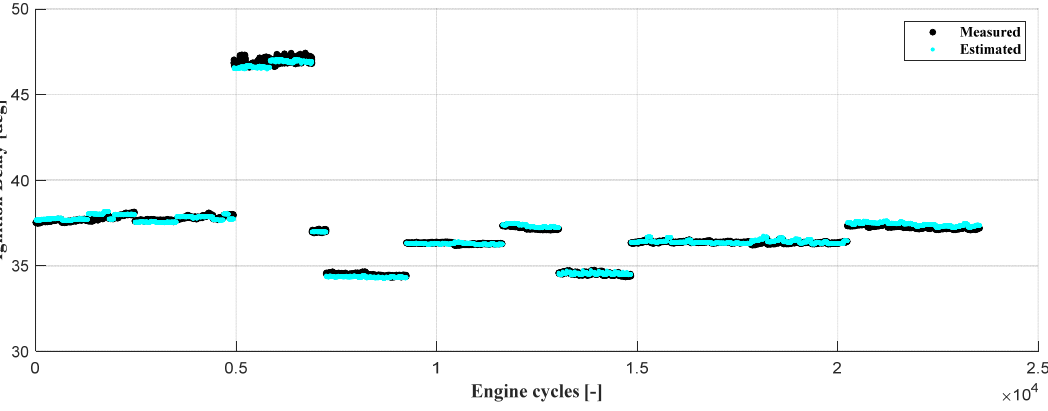
Figure 20. Accuracy on cycle-by-cycle SOC estimation for switching pattern tests: top subplot comparison between measured and estimated ID, bottom subplot error evaluation.